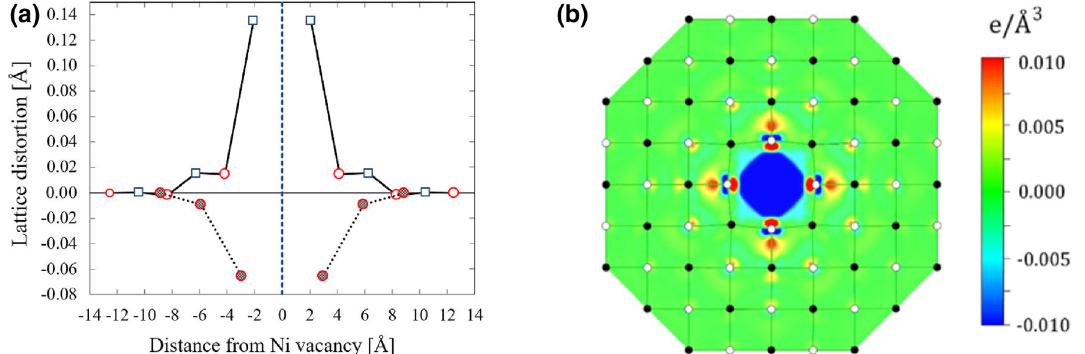
Figure 5. ( a ) Lattice distortion induced by a charged Ni vacancy (V Ni 2 − ). Distortions along [100] and [110] crystallographic axes are plotted with solid and dotted lines, respectively. Circles and squares denote Ni and O atoms, respectively. Positive and negative values of the lattice distortions indicate an outward and inward deformations, respectively. ( b ) Charge density difference induced by the Ni vacancy (V Ni 2 − ) in the (001) plane. Negative (blue colour) and positive (red colour) corresponds to a reduction or an increase of the charge density compared to the bulk cell,